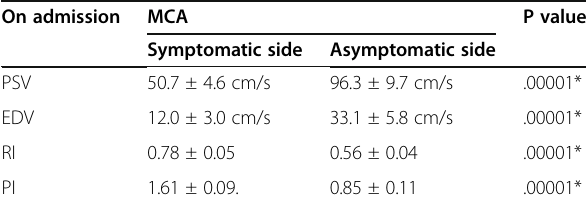
Table 2 Comparison of duplex parameters between symptomatic and asymptomatic side in MCA on admission On